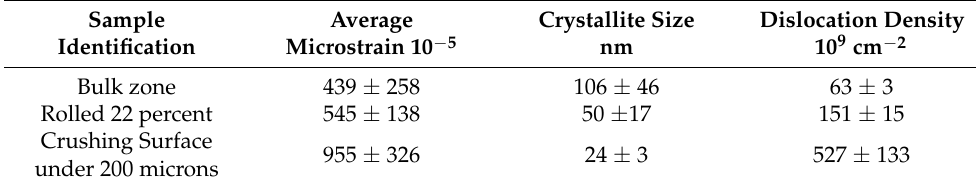
Figure 9. X-ray diffraction peak analysis. Effect of strain vs. ( a ) (111) peak broadening and ( b ) the conventional Williamson–Hall plot. Table 1. Summary of X-ray diffraction peak